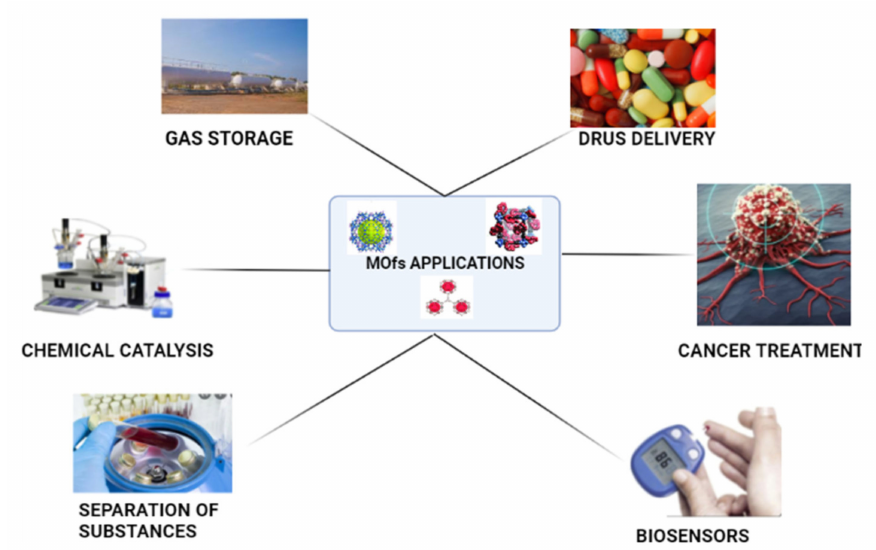
Figure 14. MOFs Schematic illustration showing the large number of MOFs